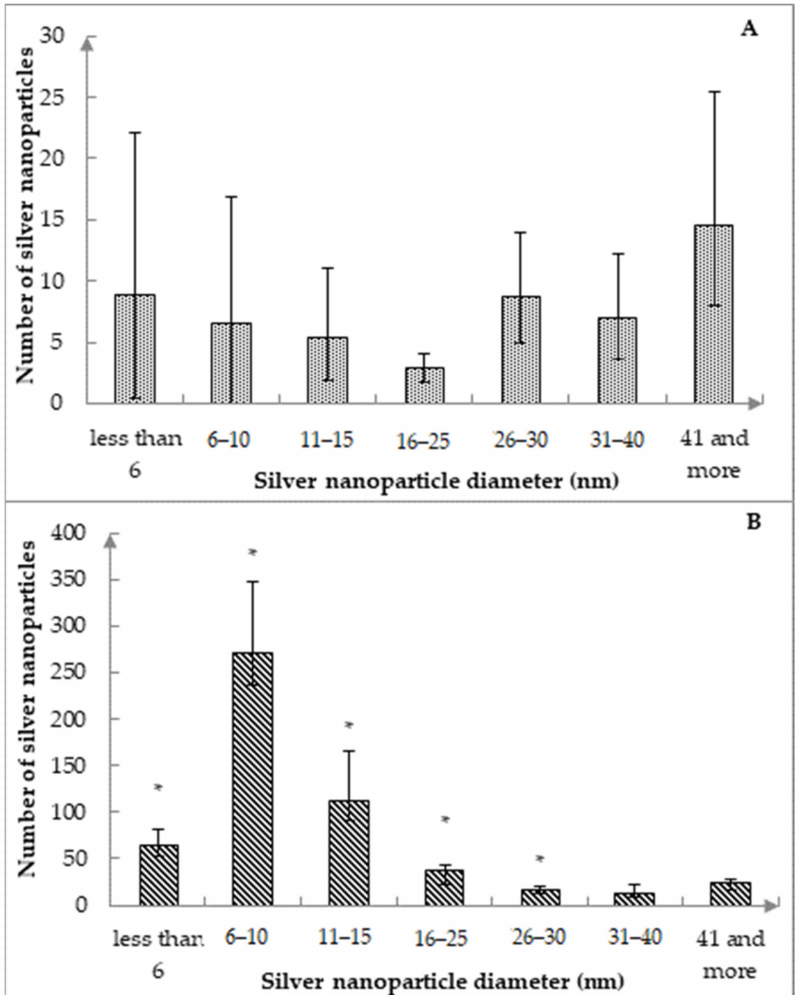
Figure 3. Distribution of silver nanoparticles on the surface of catgut suture material without exposure to temperatures below 0.0 ◦ C ( A ) and after 10-fold cyclic freezing ( B ). Note: *— p < 0.05, in comparison with the same size range before cyclic freezing; data are presented as Me, P 25 , P 75